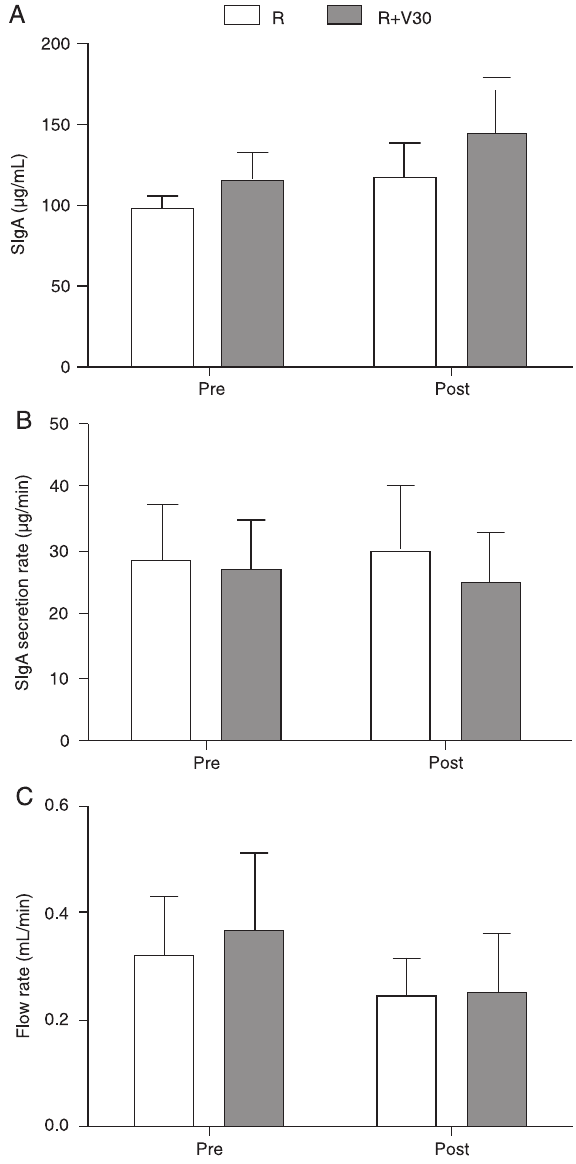
Figure 2. A , Salivary immunoglobulin A (SIgA) concentration (µg/mL); B , SIgA secretion rate (µg/min); C , salivary flow rate (mL/min), before and immediately after the two exercise